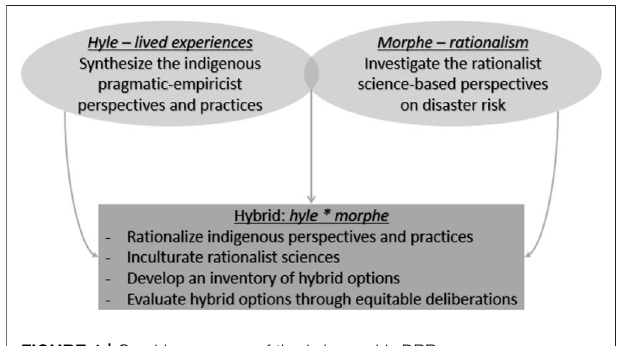
FIGURE 1 | Graphic summary of the hylomorphic DRR framework — Adapted from Bwambale et al.